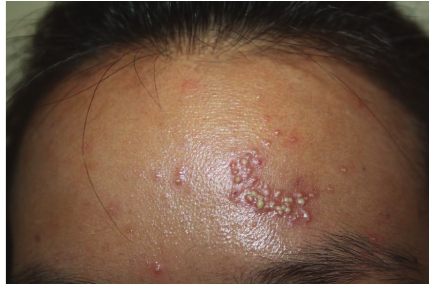
Figure 4: A 31-year-old female presented with ALEP on the face 1 day after taking herbal